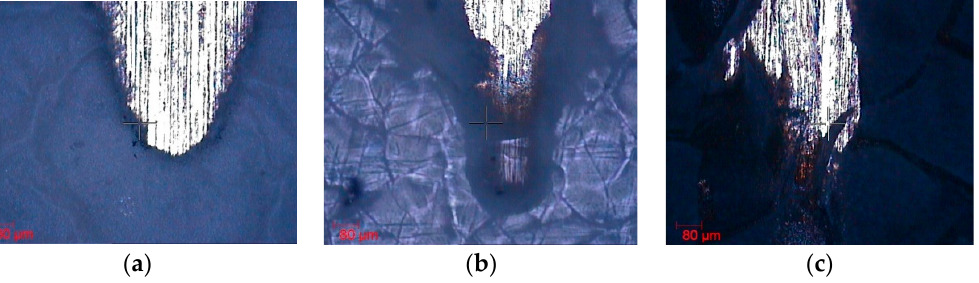
Figure 6. Optical images show the surface trace of the samples S2 ( a ), S3 ( b ), and S4 ( c ) at the scale of 80 µm, when the critical load is reached.